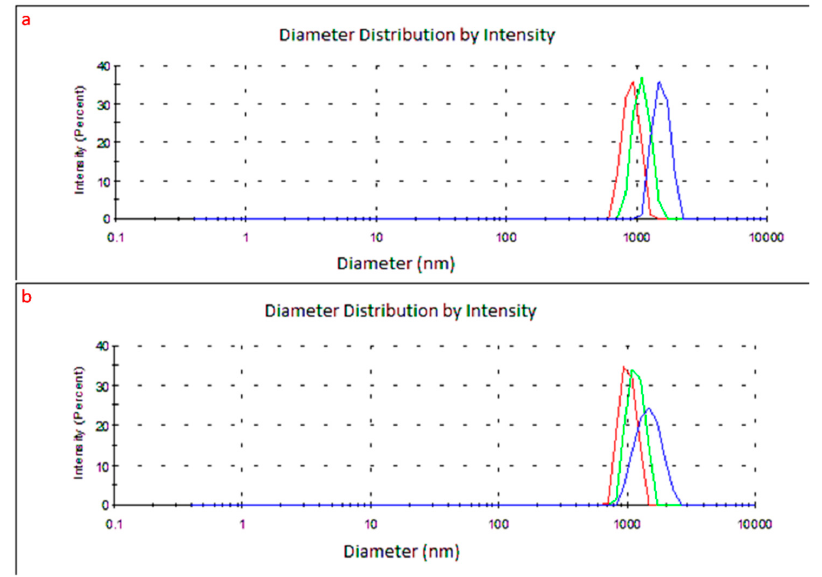
Figure 4. Graphical representation of PC liposomes diameter without encapsulated extract of Stel- laria media (L.)Vill. ( a ) and PCE liposomes with encapsulated extract of Stellaria media (L.)Vill. ( b ). The diameter of PC-type liposomes was between 712 and 1900 nm; 85% of them were in the range 712–1000 nm. The remaining 15% were over 1000 nm, but none were higher than 1900 nm (Figure 5a). The PCE diameter was also between 712 nm and 2000 nm. A total of 52.5% of the PCE liposomes were between 712 nm and 1000 nm and the remaining 47.5% were over 1000 nm, but none were higher than 2000 nm (Figure 5b).